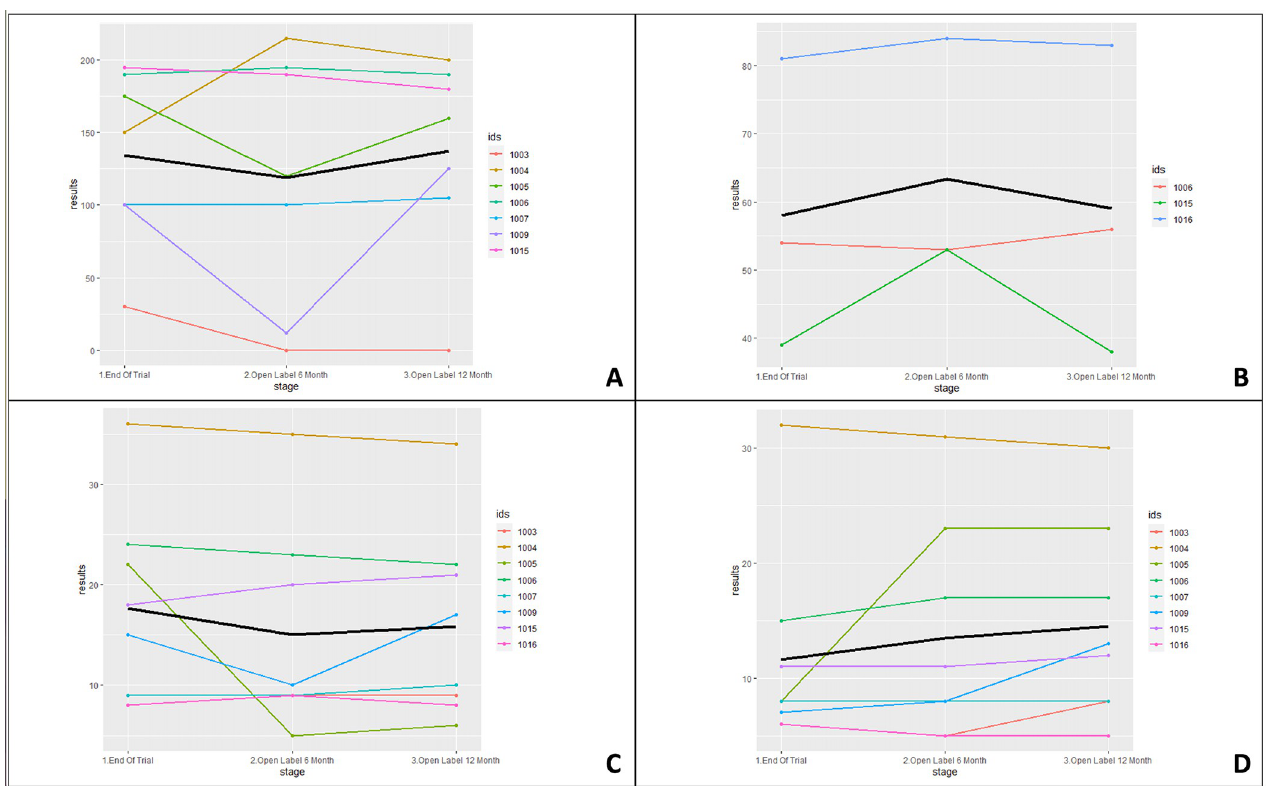
Fig 3. Results of the OLE study across 6 and 12 months. A summary of four of the secondary outcome measures separated into three timepoints—the end of the trial, 6 months and 12 months. The black line in the graphs refers to the average. Ids = participant IDs. A . Results of the 2MWT (m). B . Results of the peak torque extension at 60 degrees (Nm). C . Results of grip right strength (kg). D . Results of grip length strength (kg).